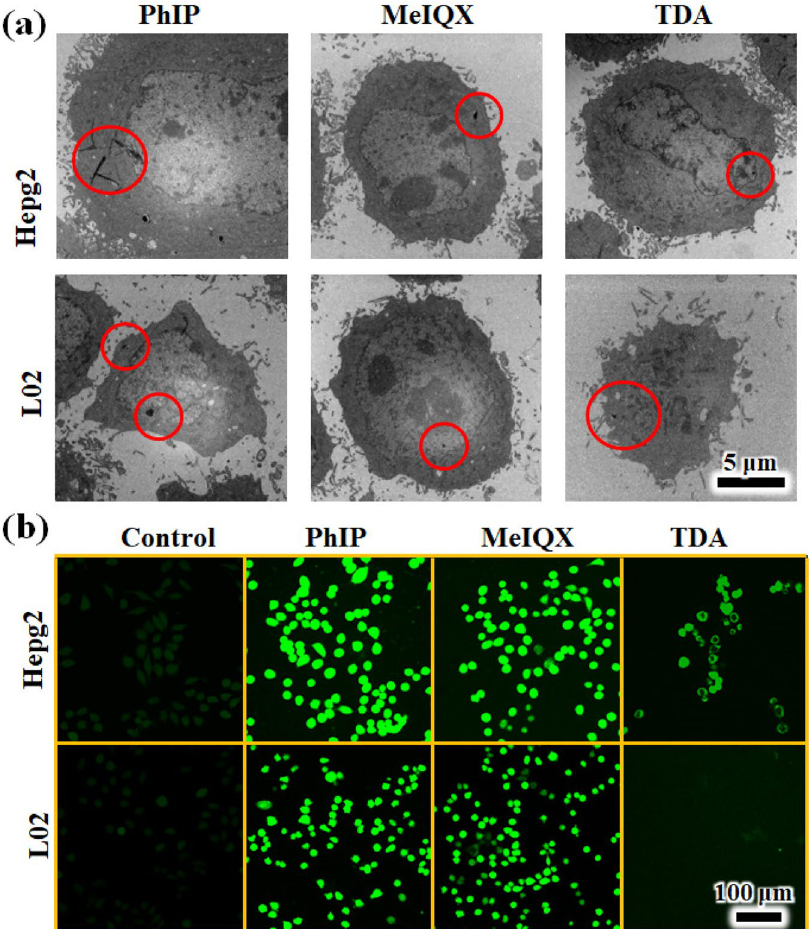
Figure 6. ( a ) TEM images of HepG-2 and L02 cells after 4 μg/mL, 200 μL, incubation for 24 h and ( b ) confocal imaging of HepG-2 and L02 cells stained with DCF-DA for the evaluation of